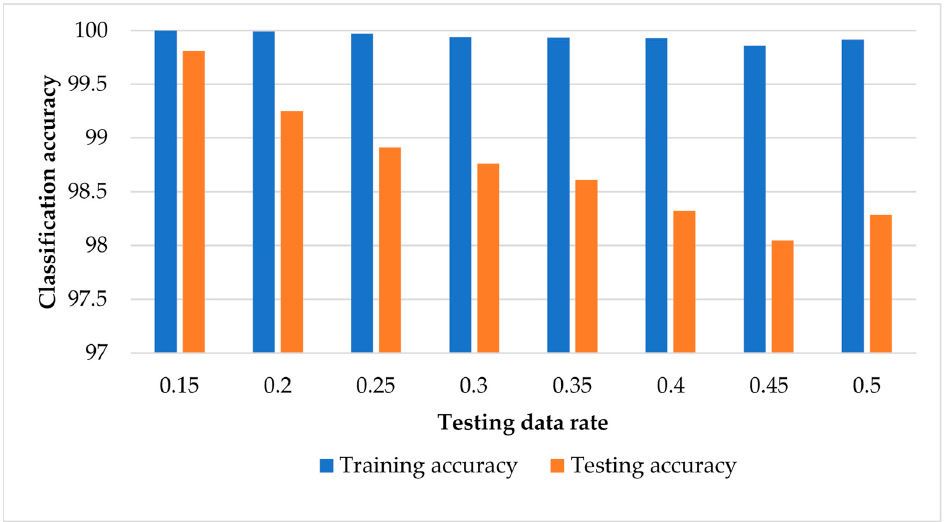
Figure 6. Classification results of training and testing data using SVM-based ECOC without data normalisation.